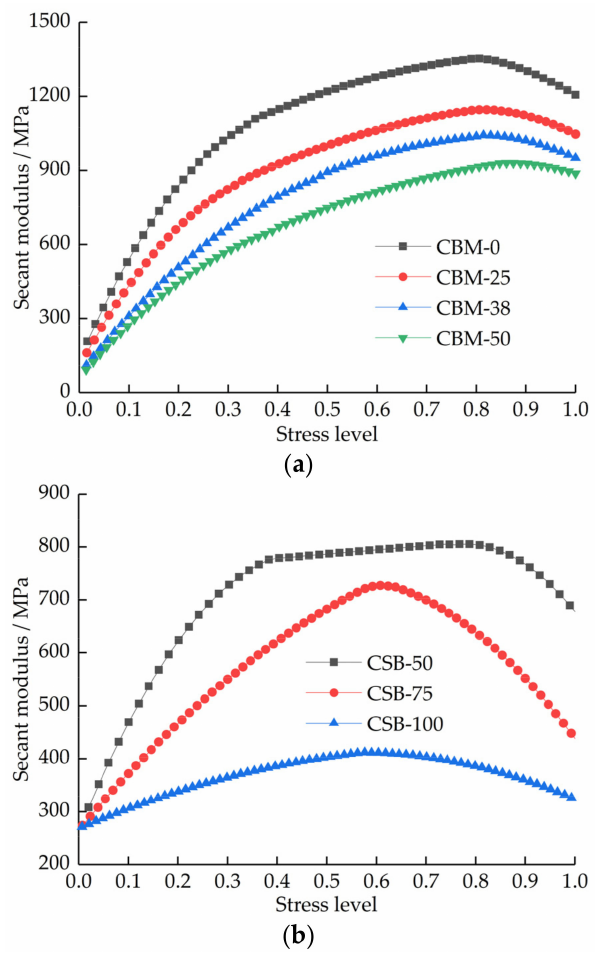
Figure 14. Curve of secant modulus under different stress levels. ( a ) CBM group. ( b ) CSB